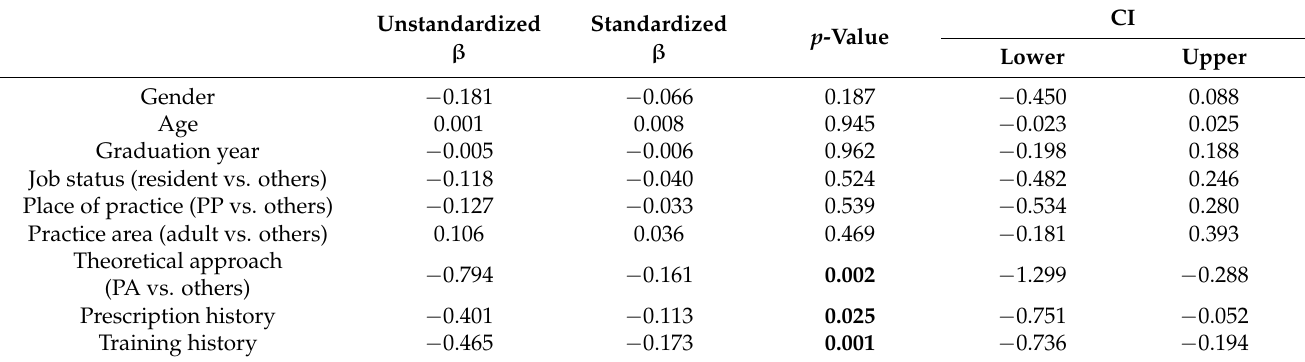
Figure 4. Mean acceptability scores according to history of training ( a ) and prescription ( b ). Table 5. Linear regression taking the overall acceptability score as the dependent